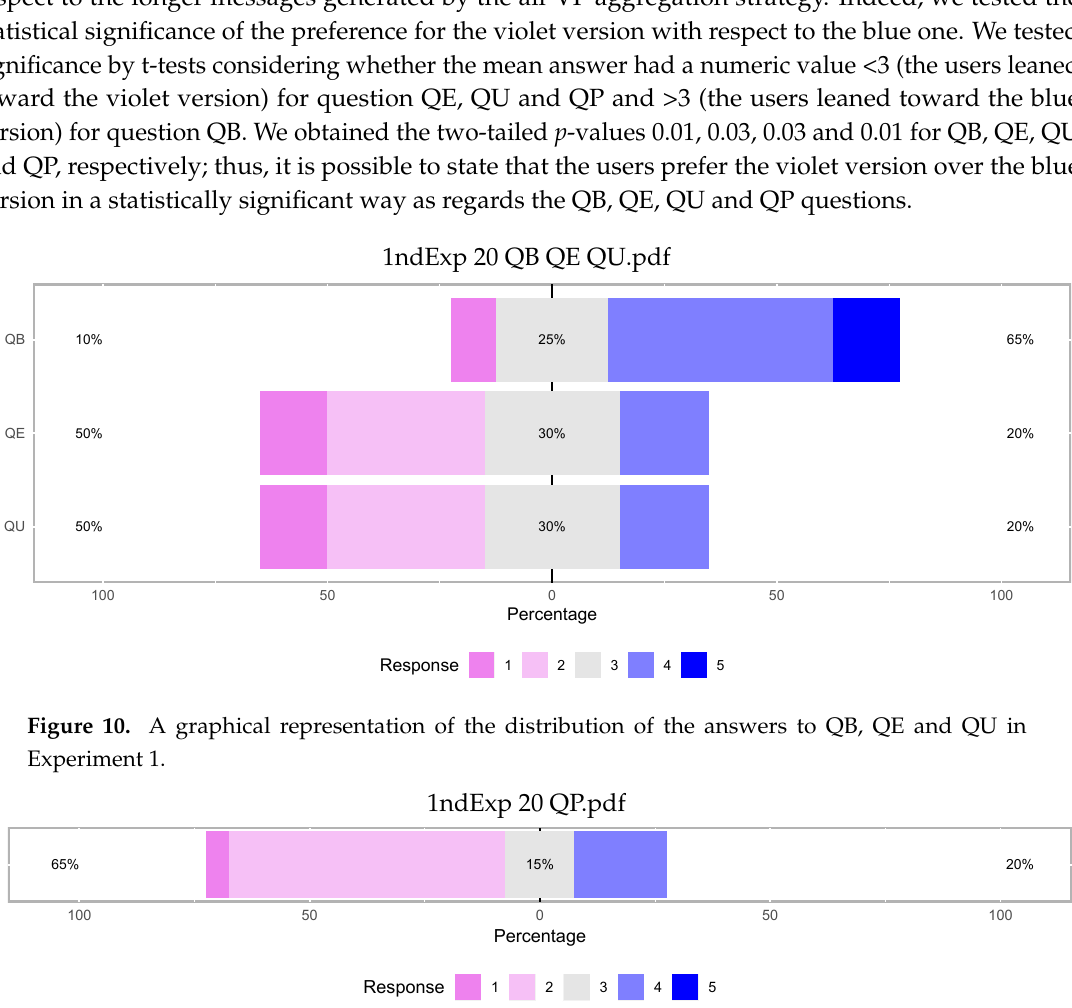
Figure 11. A graphical representation of the distribution of the answers to QP in Experiment